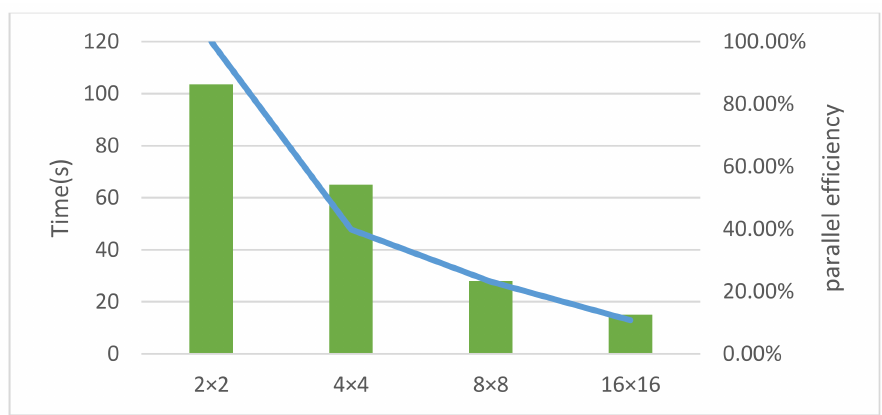
Figure 12. Optimized heterogeneous parallel strong scaling